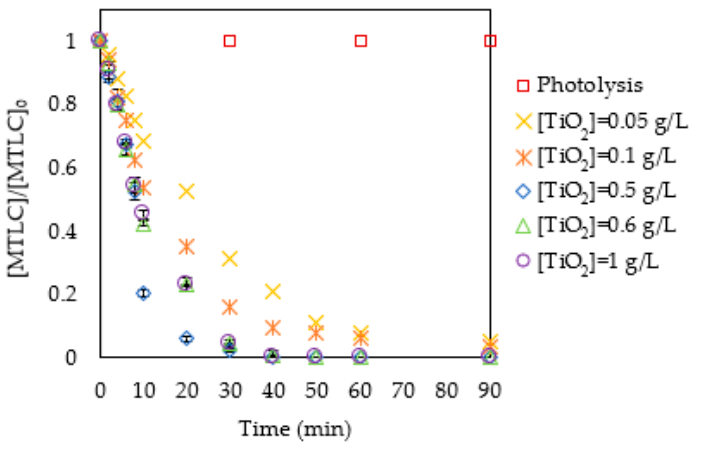
Figure 3. Dimensionless S-Metolachlor (MTLC) concentration removal at pH 3.